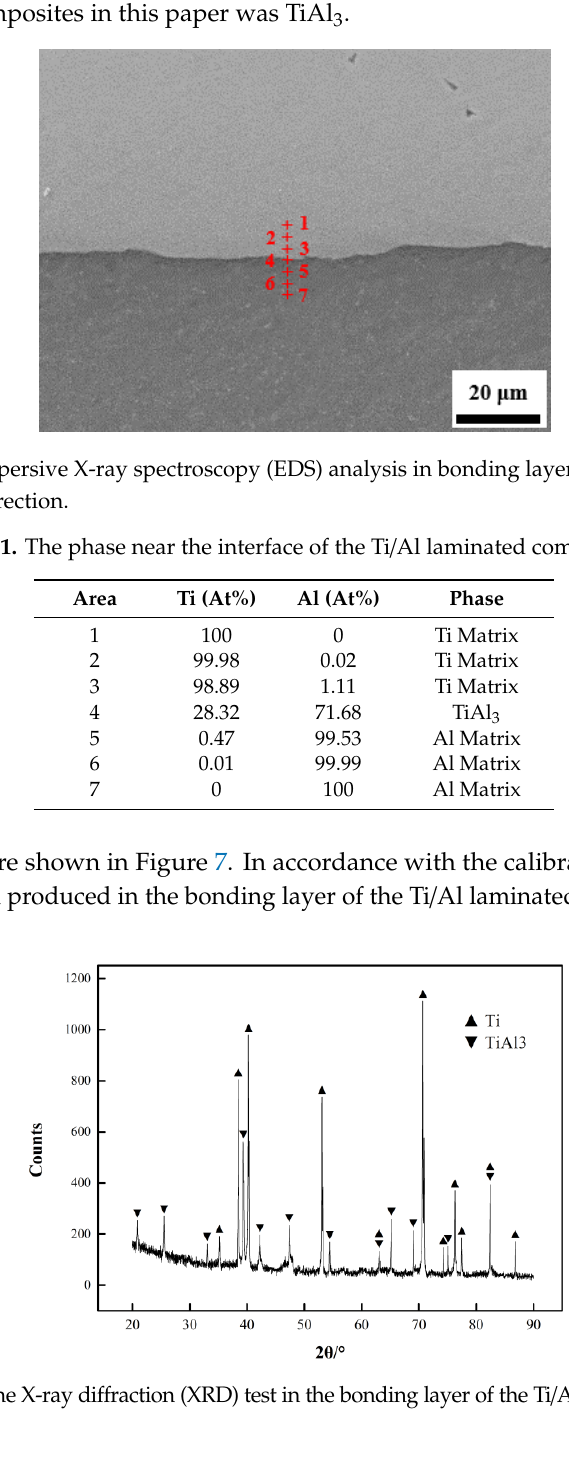
Table 1. The phase near the interface of the Ti/Al laminated composites.